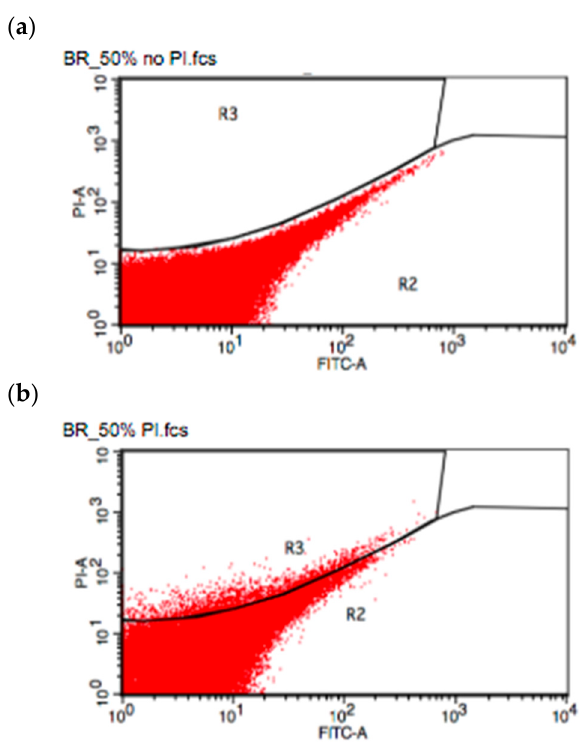
Figure 6. Representative fluorescein isothiocyanate (FITC) plots of particles without PI ( a ) and with PI stain ( b ).